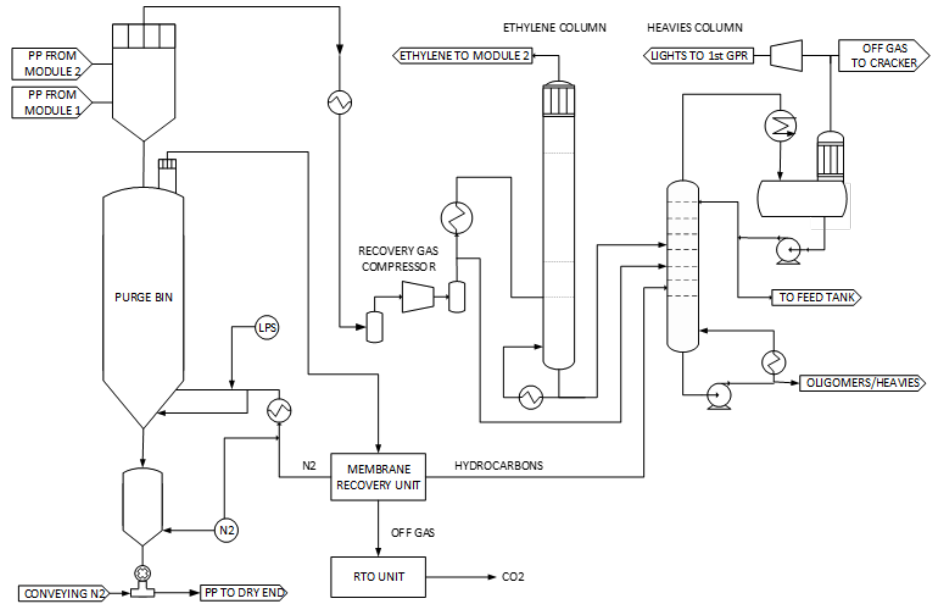
Figure 4. Simplified schematic flow diagram of the purge and recovery section of the Borstar ® PP process.